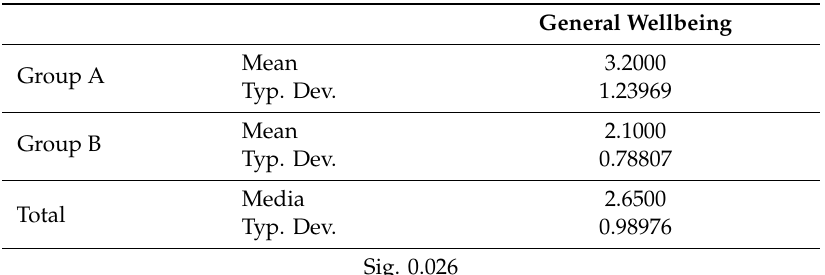
Table 16. E ff ect of the learning group on the sensation of general wellbeing.